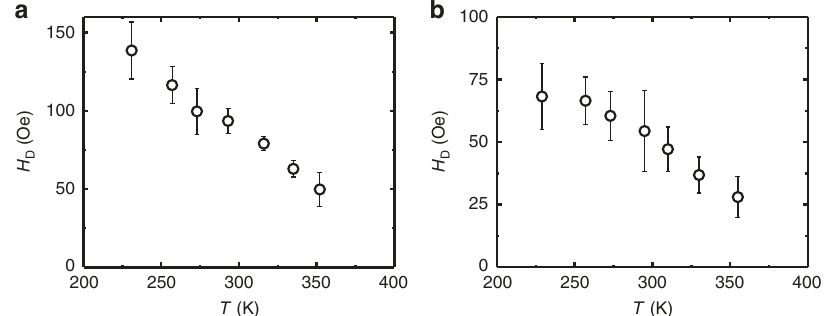
Fig. 6 Temperature dependence of DMI. The DMI effective fi eld ( H D ) as a function of temperature ( T ) in a GGG/TmIG (2.4 nm)/Pt (4.0 nm) and b GGG/ TmIG (6.0 nm)/Pt (4.0 nm). Error bars are standard error of three measurements. Source data are provided as a Source Data fi